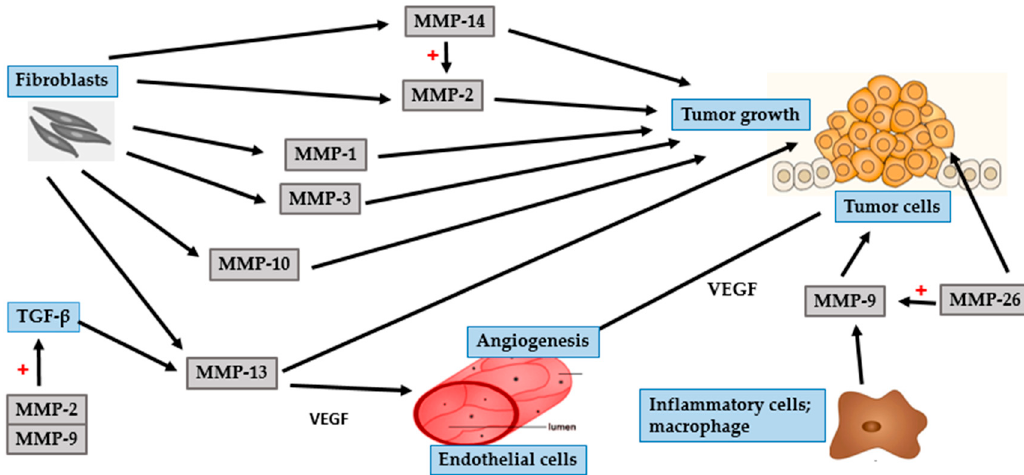
Figure 4. Role of MMPs in SCC and tumor growth. Fibroblasts secrete MMP-1, MMP-2 (also activated by MMP-14), MMP-3, MMP-10, MMP-13 (also enhanced by TGF- β that is activated by MMP-2 and MMP-9), and MMP-14 to promote tumor growth. In addition to tumor initiation, MMP-13 is involved in the maintenance of angiogenesis through the release of VEGF. Inflammatory cells-derived MMP-9 induces SCC cells to release VEGF to support tumor angiogenesis. MMP-26 can activate MMP-9 and promote tumor growth.